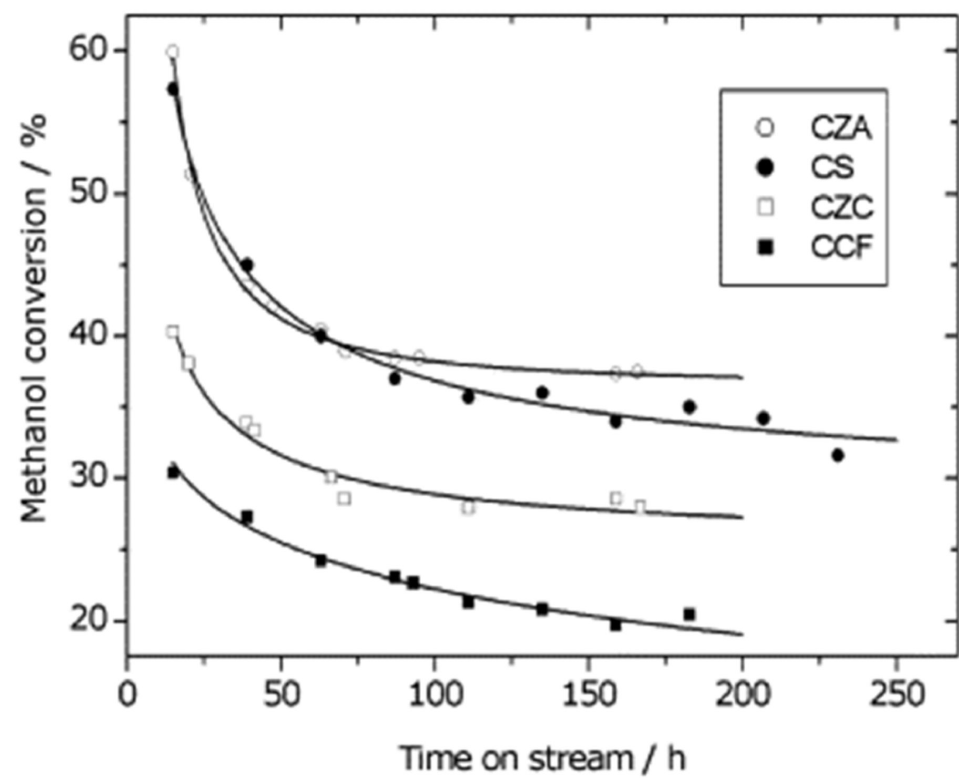
Figure 6. Catalyst deactivation of Cu-based catalysts during the SRM reaction as a func- tion on time of stream. Experimental conditions: T = 220 ◦ C, p = 1 bar, S/C = 1. (CZA: Cu/ZnO/Al 2 O 3 , CS: Cu/SiO 2 , CZC: Cu/ZnO/CeO 2 , CCF: Cu/Cr 2 O 3 /Fe 2 O 3 ). (Adapted from [81], copyright 2007,